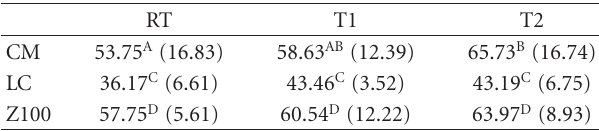
Table 4: Means and (SD)s of diametral tensile strength values for the three composite materials in MPa. Means with same superscript letter did not significantly di ff er statistically ( P > 0 .